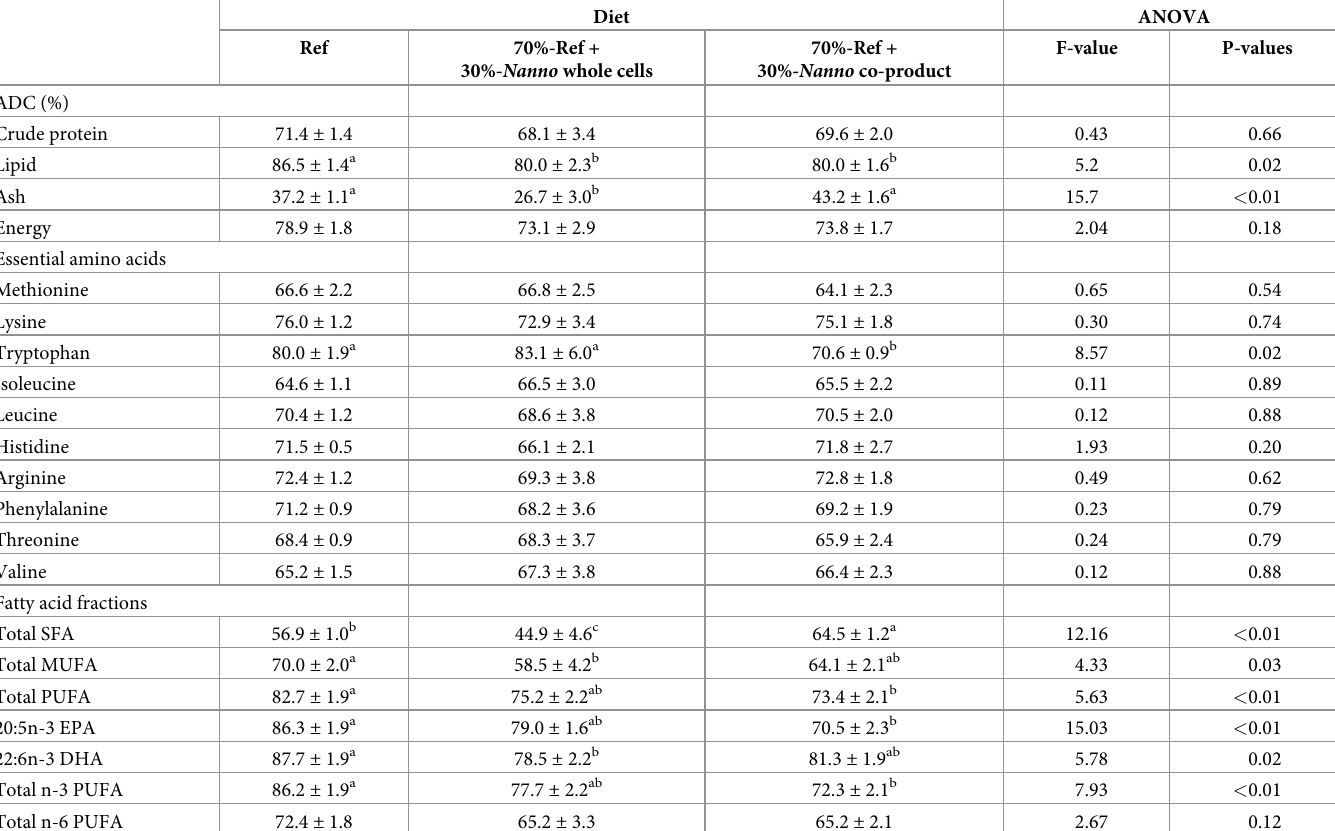
Table 9. Apparent digestibility coefficients (ADC) (cid:3) of nutrients, gross energy, essential amino acids and fatty acids in the reference diet and two test diets for